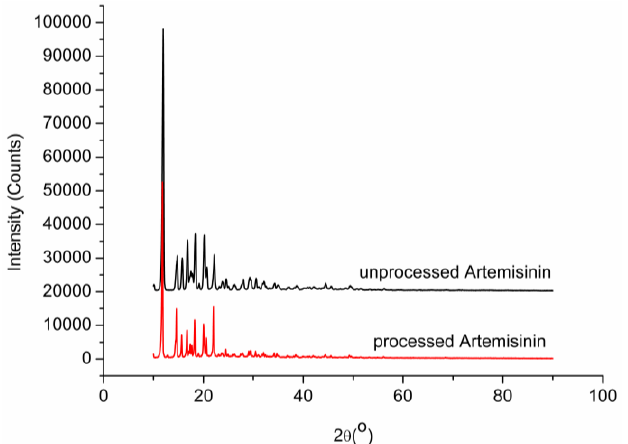
Figure 7. Comparison of artemisinin XRD traces before and after RESS